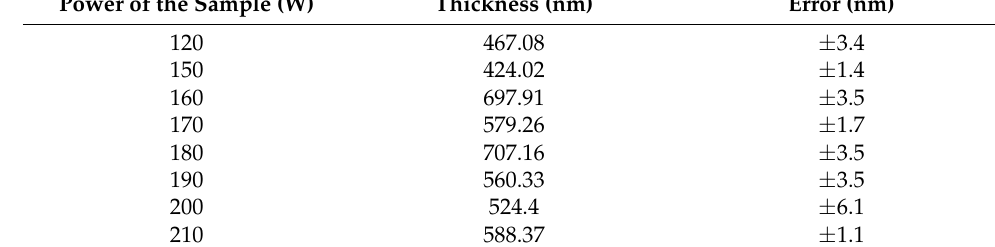
Figure 5. AFM image in isometric view of the thickness profile of the synthesized TaN sample produced at 210 W. Table 1. Thicknesses of TaN films synthesized at different powers.